Question: Which visualization type does this figure use?
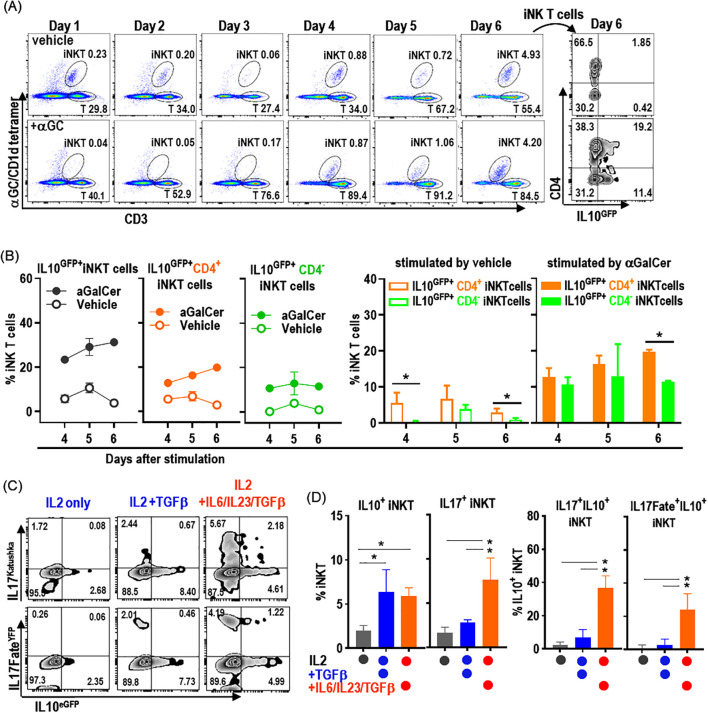
Answer: bar